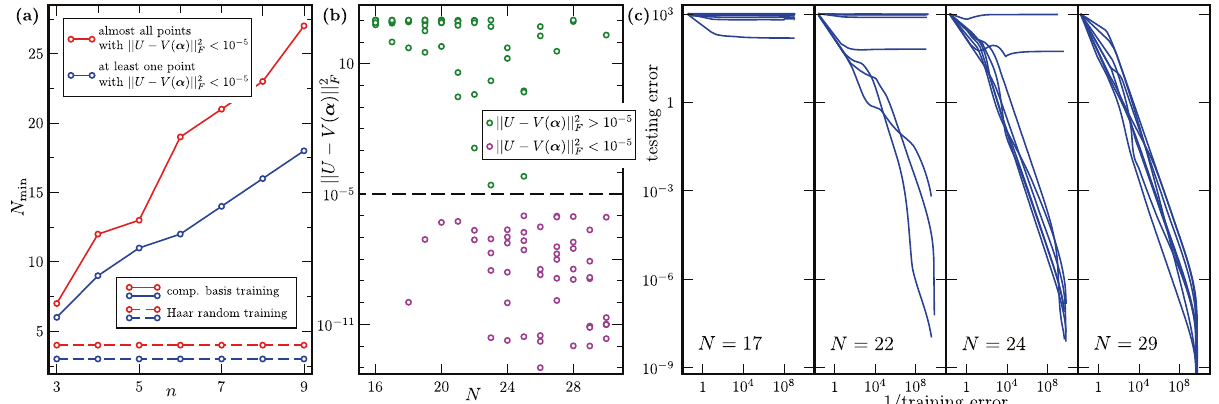
Fig. 3 | Generalization performance of variational unitary compiling. We employed a variable structure QMLM (as discussed near Theorem 4). Panel ( a ) shows the dependence of N min , the minimum training data size for accurate com- pilation, on n , the number of qubits. Accurate compilation is de fi ned as achieving k U (cid:5) V ð α Þk 2 F <10 (cid:5) 5 on1outof8(blue)oron7outof8(red)runs.Fortrainingdata withrandomcomputationalbasisinputs(solidlines), N min scaleslinearlyin n .When trainingonexampleswithHaarrandominputs(dashedlines), N min isconstantupto system size n =9. In Panel ( b ), for n =9 qubits, we plot the prediction error of